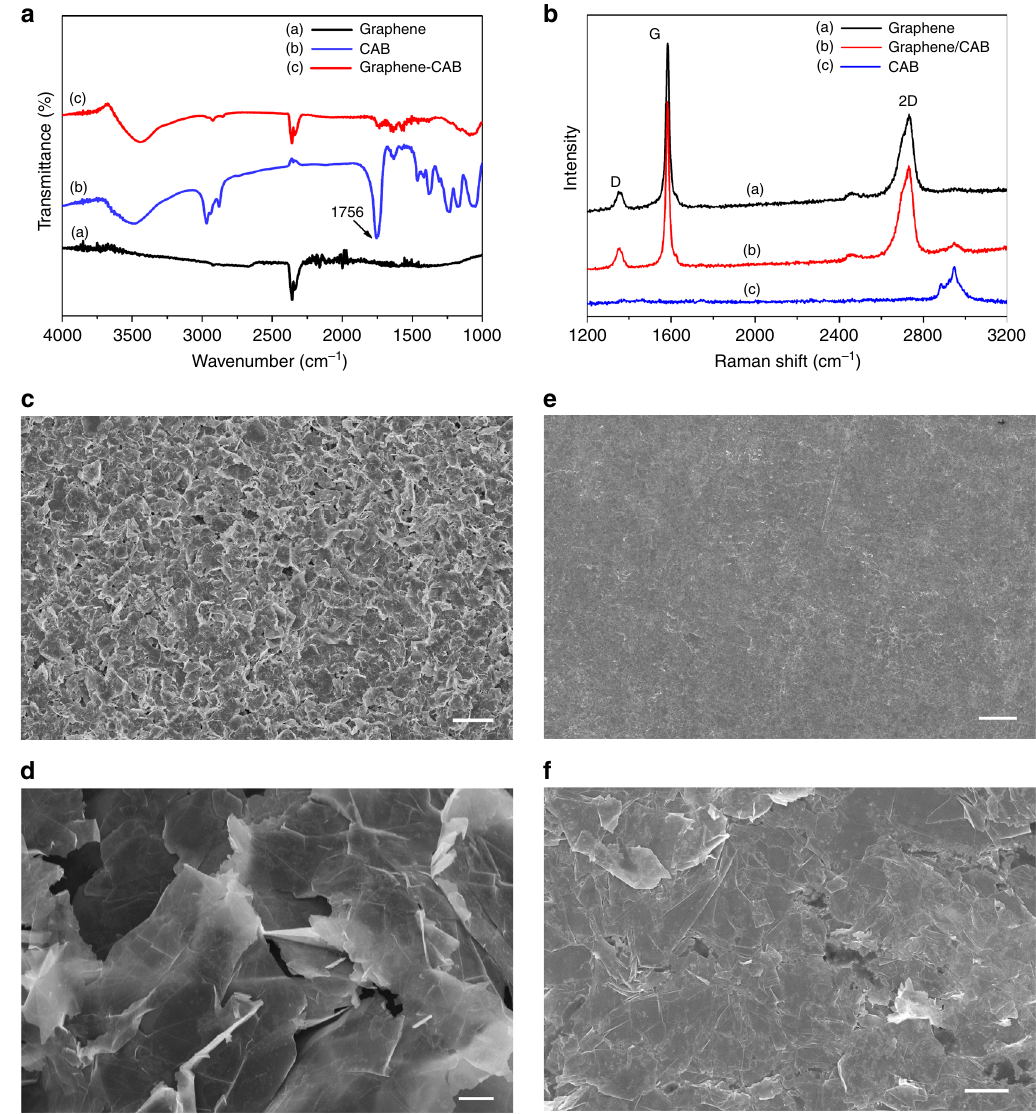
Fig. 2 Quality of the screen-printed graphene laminate: a FTIR characterization of Cyrene graphene ink with and without CAB, b Raman spectra of Cyrene graphene ink with and without CAB and c – f SEM images of screen-printed graphene on paper ( c uncompressed and e compressed screen-printed graphene laminates with ×300 magni fi cation; scale bar is 30 µ m, d uncompressed and f compressed screen-printed graphene laminates with ×10k magni fi cation; scale bar is 1 µ